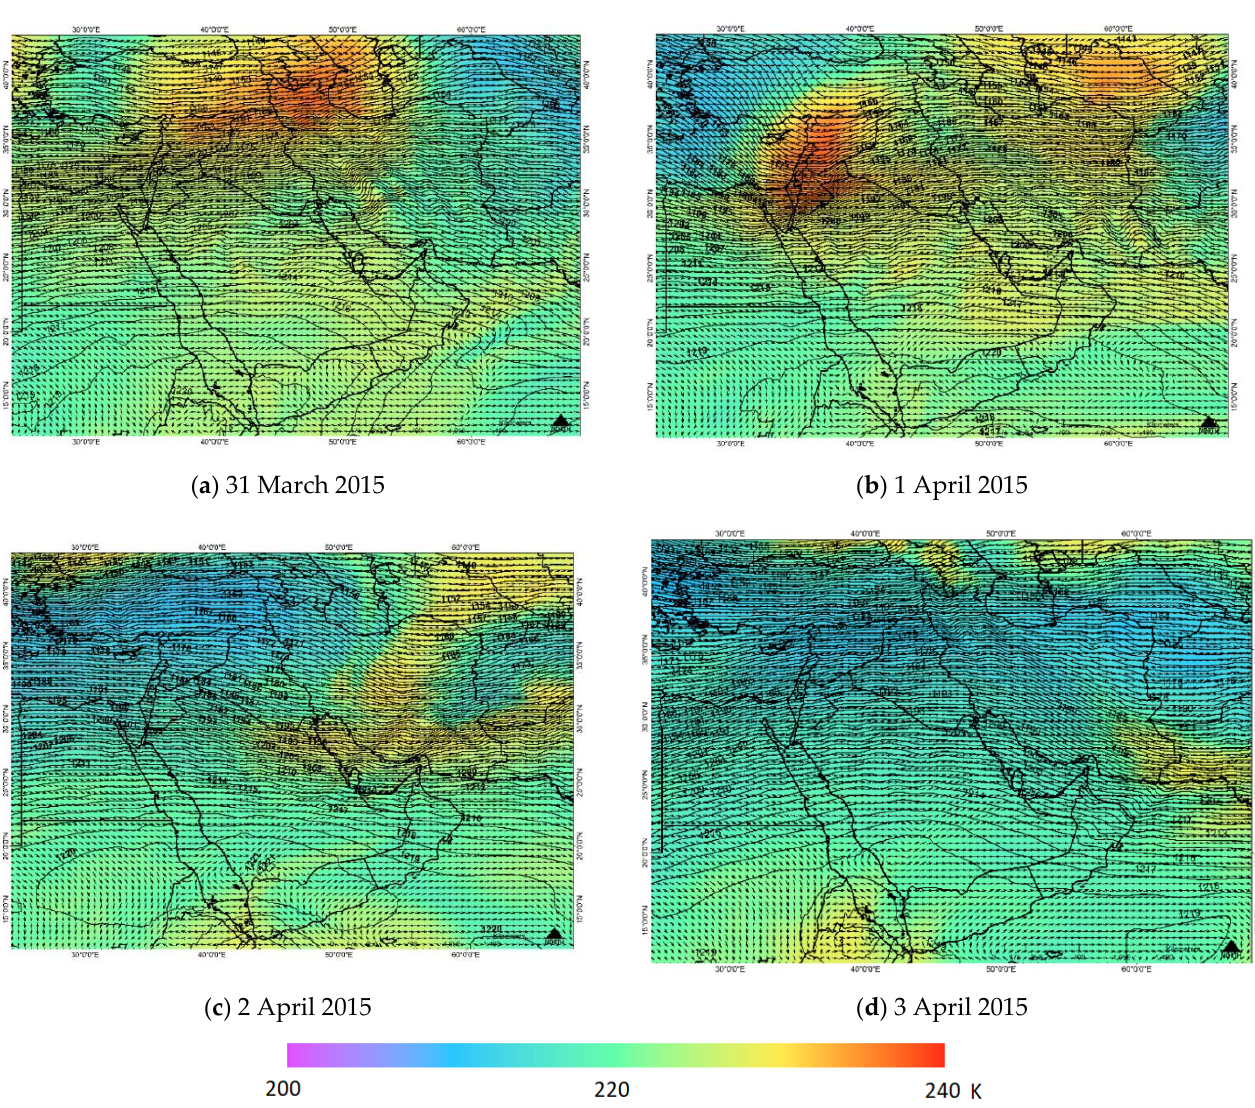
Figure 4. The daily upper tropospheric (200 hPa) zonal winds (m/s) and temperature (K) derived from ERA5 ECMWF reanalysis data between 31 March and 3 April (12:00 UTC) ( a – d ).